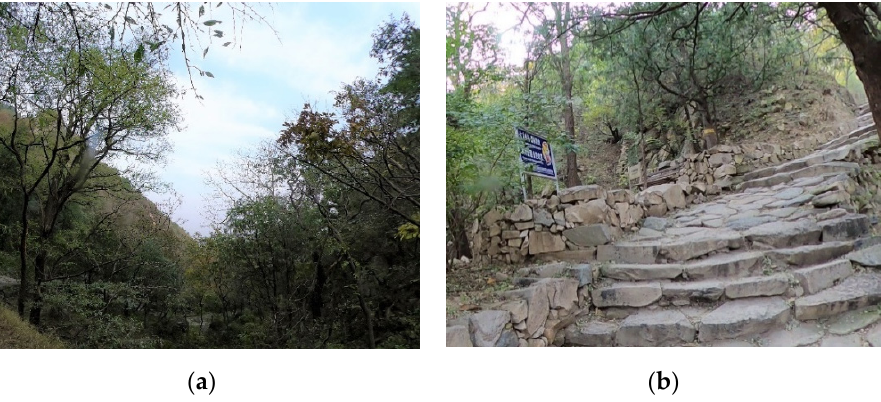
Figure 2. Forest landscape and artificial facilities in Mangshan National Forest Park (MS): ( a ) Forest landscape; ( b ) Artificial facilities.